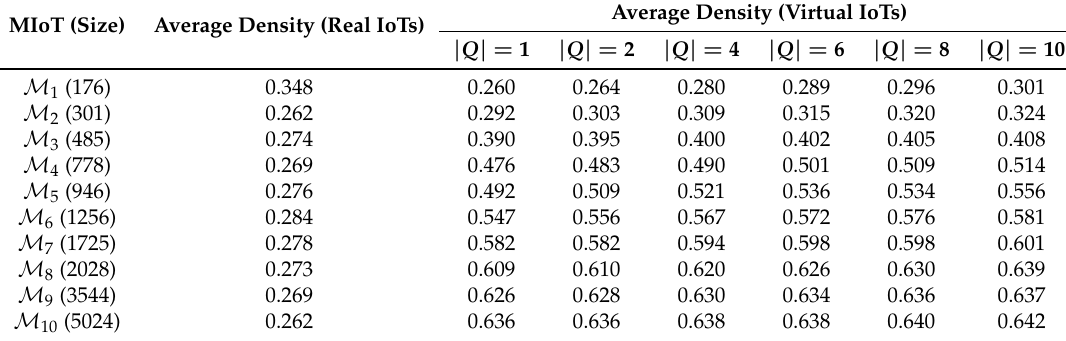
Table 3. Values of the density for real and virtual IoTs against the size of MIoTs and queries used to generate the virtual IoTs (supervised